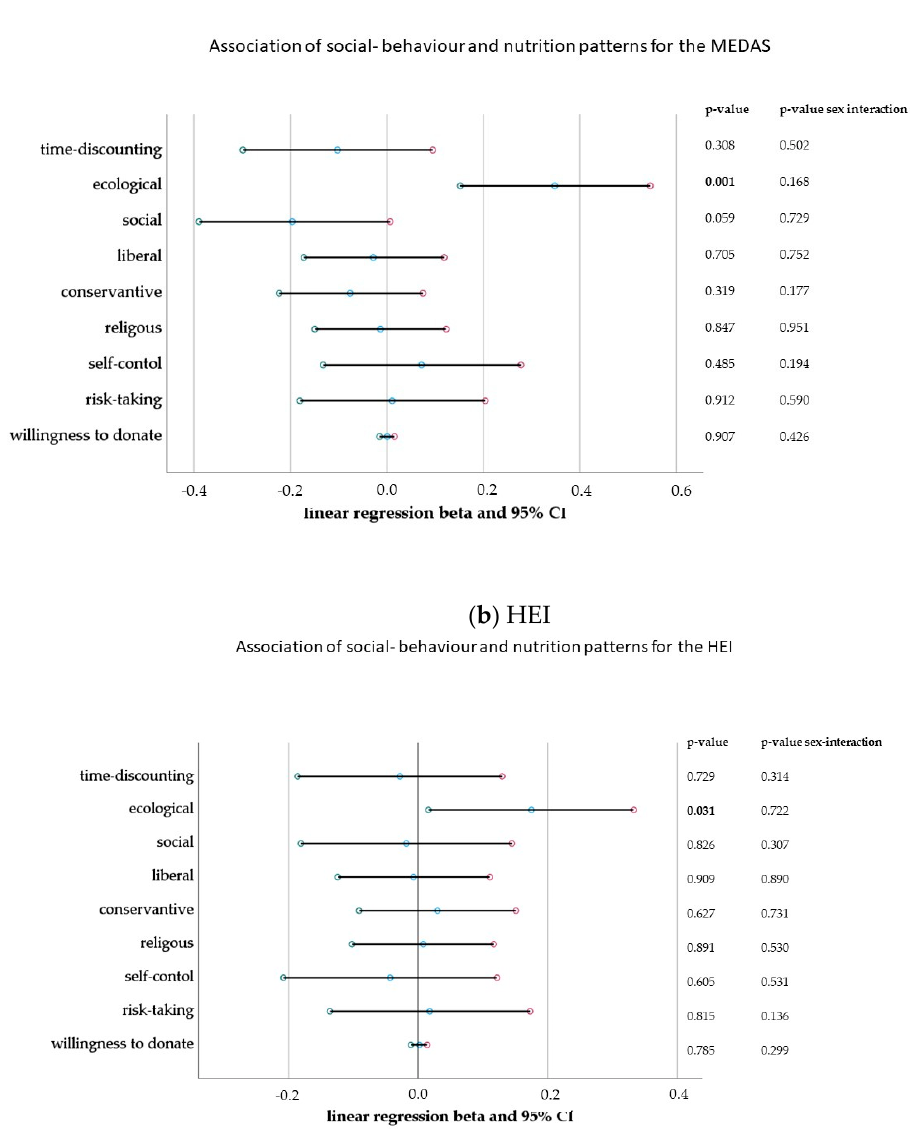
Figure 2. ( a ) Association of social behaviour items with the MEDAS. Linear regression model: R2 = 0.200; p = 0.011. Detailed numerical results are presented in Supplementary Tables S6 and S8. ( b ) Association of social behaviour items with the HEI. Significant associations ( p < 0.05) marked in bold. Linear regression model: R2 = 0.082; p = 0.515. Detailed numerical results are presented in Supplementary Tables S5 and S7. Significant associations ( p < 0.05) marked in